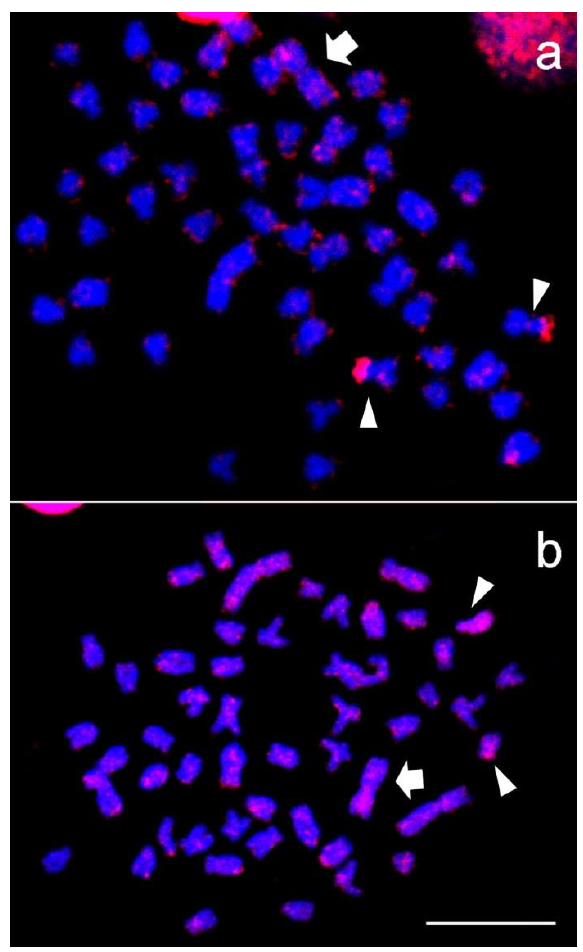
Figure 2. Chromosome mapping with the probes Tc1-Mariner ( a ) and LINE ( b ) in Astyanax scabripinnis . B chromosomes are indicated by the big arrows. Tc1-Mariner presents preferential accumulation in the short arm of a medium metacentric pair (little arrow) and small blocks in the other complement chromosomes. LINE has a pattern of localization dispersed in the other chromosomes, with strong accumulation along a pair of complement submetacentric chromosomes (arrows). Bar = 10 µm. In contrast with the 5-mC and in situ hybridization, the indirect immunofluorescence of the Tc1-Mariner and LINE probes suggests that the transposable element regions are methylated (Figure